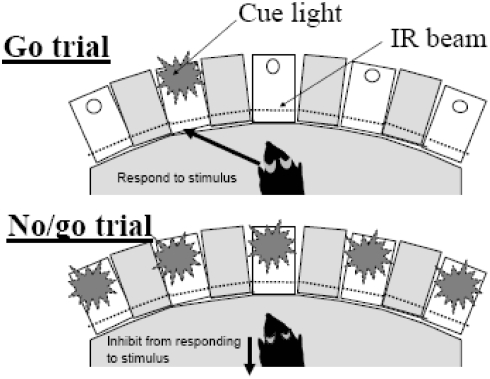
Schematic of the 5C-CPT stimuli.Example of the two trial types in the 5C-CPT. Go trials (relevant stimuli) appear 83% of the time, and the mouse must respond to the stimulus by nose-poking beyond the infra-red (IR) beam in the location of the cue stimulus. Cue stimuli can appear in any one of the five locations. No/go trials (irrelevant stimuli) occur 17% of the time, all five cue lights come on, and the mouse must inhibit from responding in any of the five locations.